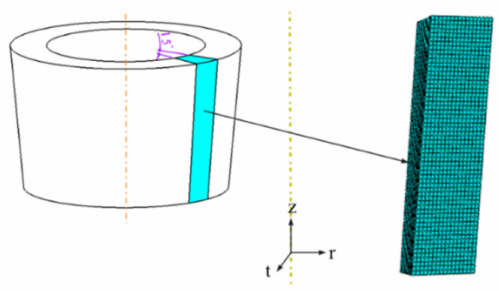
Figure 6. Simplified simulation model and mesh generation.